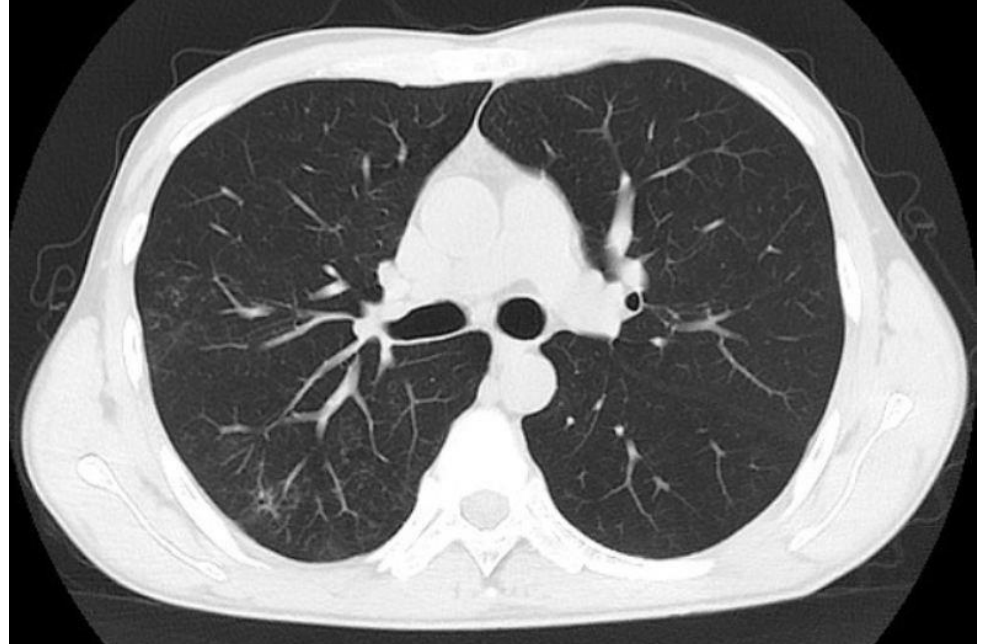
Figure 4. June 2021, after 2 months of treatment with levofloxacin, inhaled amikacin sulfate and low-dose prednisone (10 mg/d). Chest CT scan showed that multiple patches and cavities in the lung were obviously absorbed.